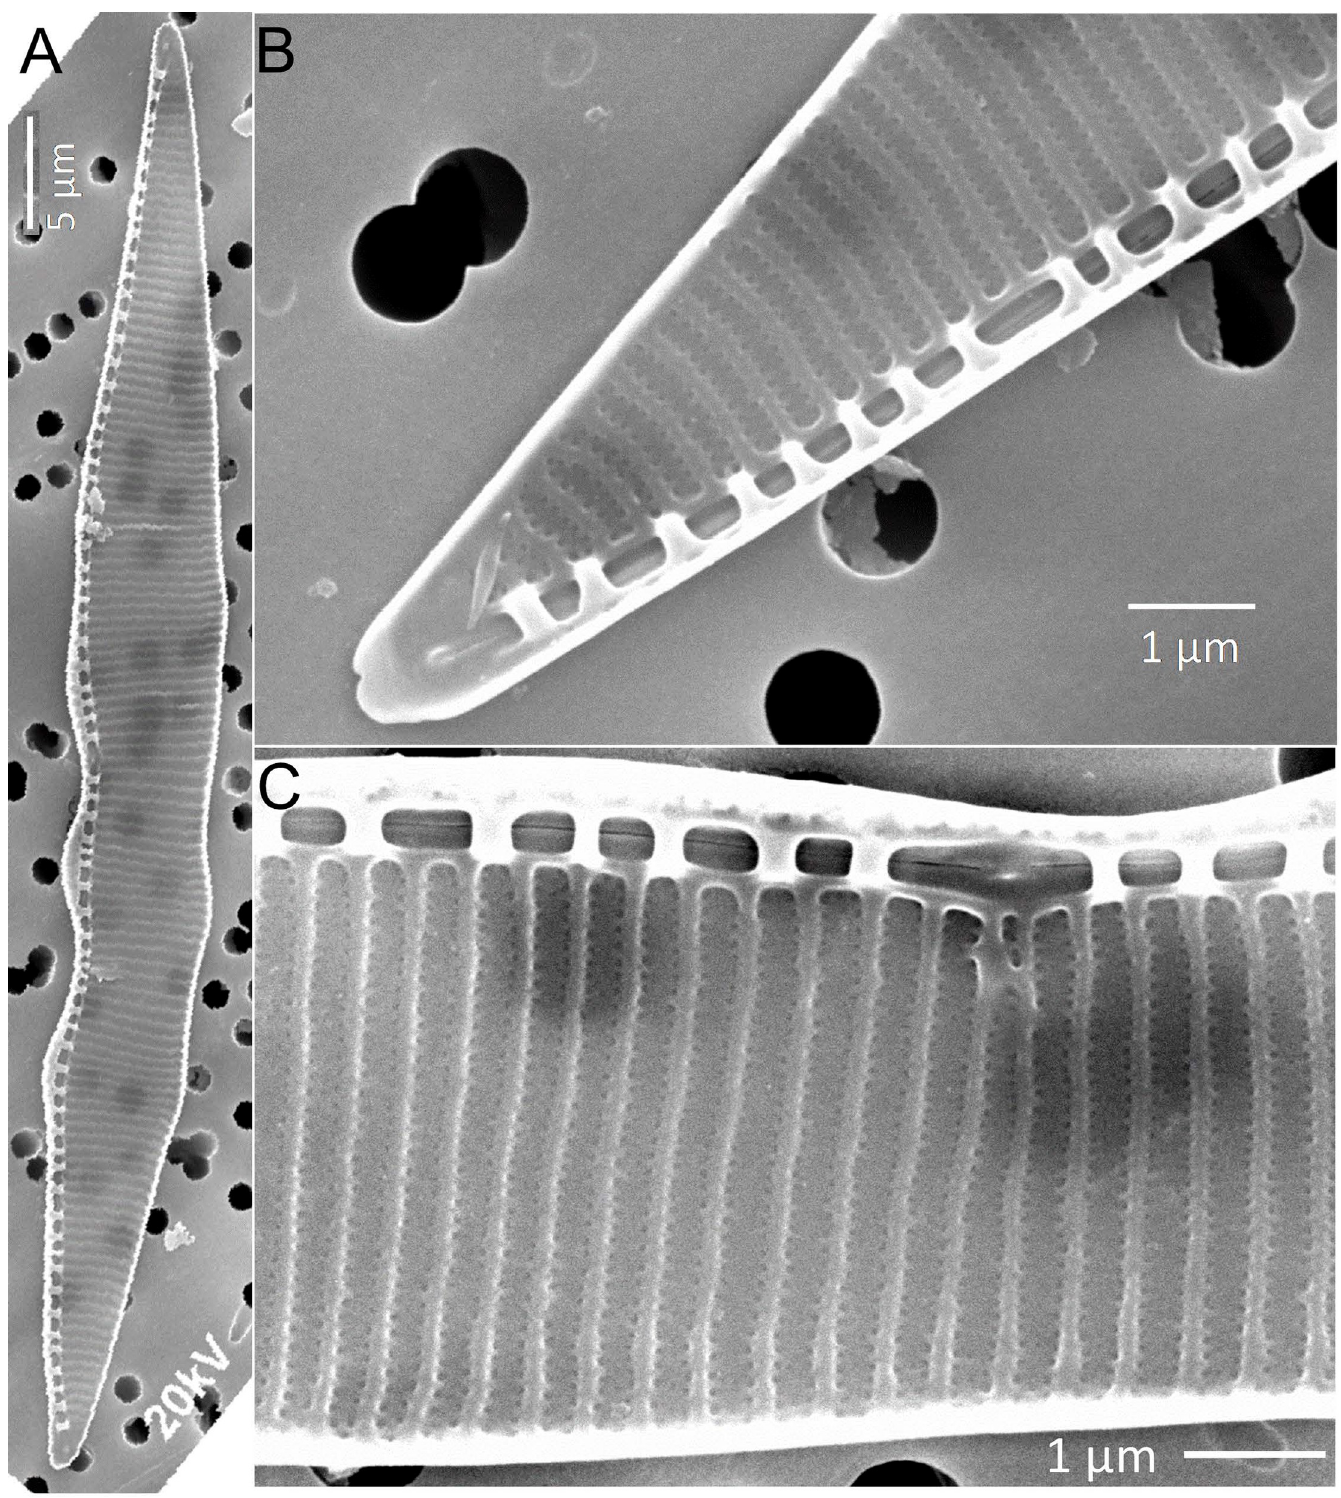
Fig 1. Pseudo-nitzschia subpacifica SEM micrographs of strain Ps 290. (A): Valve view of the whole valve showing central nodule, fibulae and striae. (B): Apex of the valve. (C): Details of fibulae and striae, showing two rows of poroids on each stria.